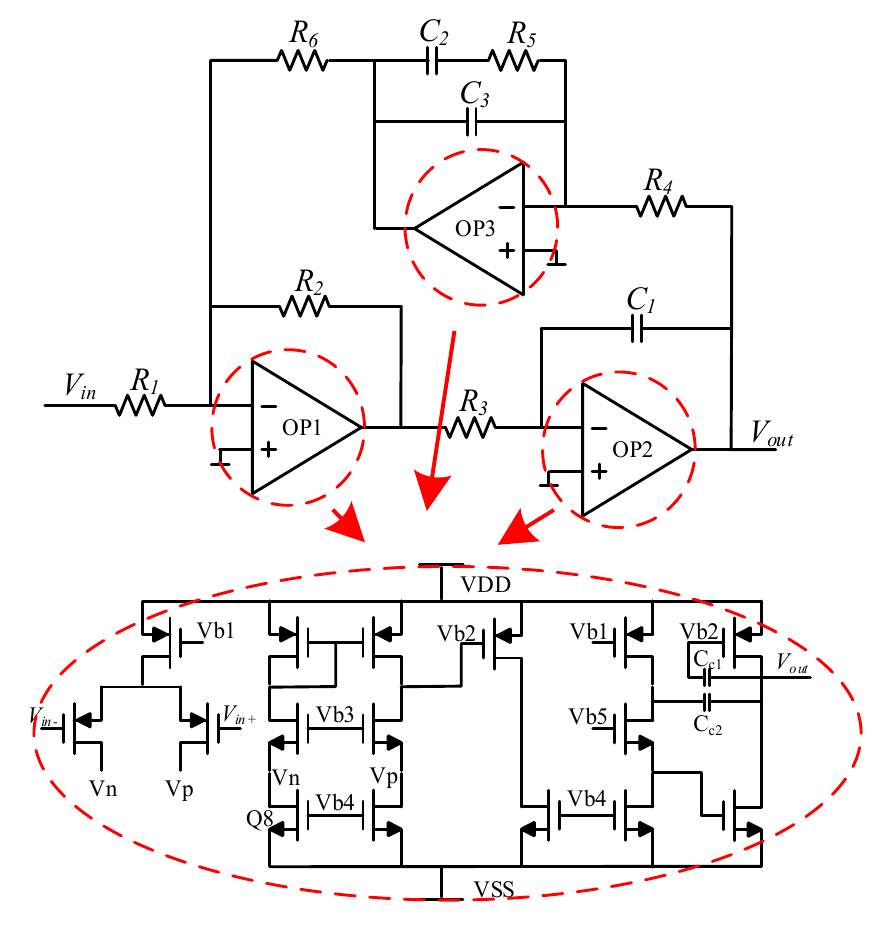
Figure 8. Diagram of phase shifter.